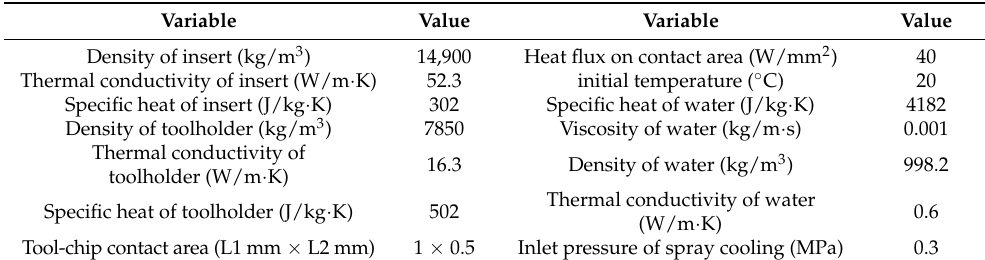
Table 1. Simulation parameters.